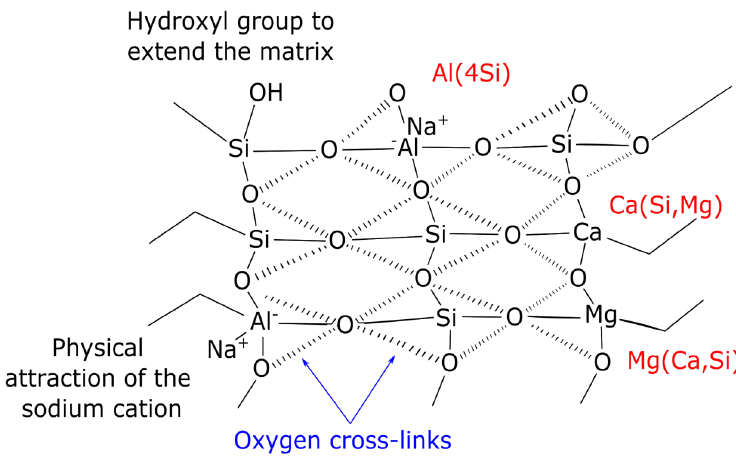
Figure 4. Proposed model of ternary C-A-S-H, and C-M-S-H gel phases [114].